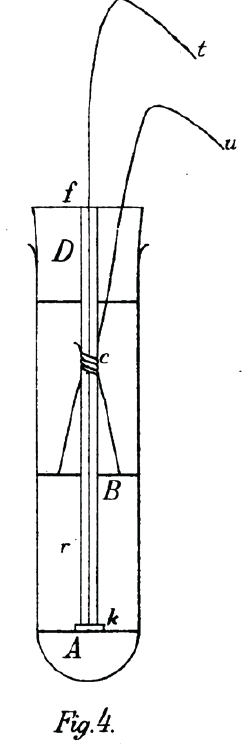
Figure 2. Scheme of the cell Arrhenius used for the measurement of the resistance. Glass vessel, height, ca. 150 mm; diameter, 25 mm. A , B : platinized platinum electrodes, 2/7 mm thickness. Lower electrode A welded to a thick platinum wire, fused into a narrow glass tube K , which passed through the center of the conical cork or rubber plug D , attached to tube r at the top at f . Upper electrode B : perforated in center to allow tube r to pass through. Two long plati- num wires, riveted to plate B , attached to the tube at point c . One of these wires formed with t one of the poles. k , small rubber plate to hermetically seal vessel at the bottom. The test liquid (30 to 40 cm 3 ) filled the vessel to a point slightly above B . Reproduced from Fig. 4 of Arrhenius´ dissertation.